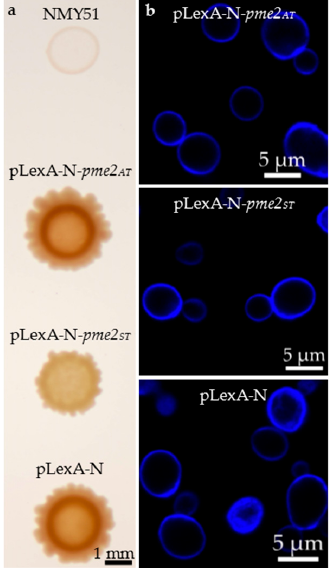
Figure 6. PME2 ST overexpression reduces viability of N. benthamiana mesophyll protoplasts. Mesophyll protoplasts were transformed with the plasmid pGGZ001 encoding mCherry-tagged PME2 ST (PME ST ) or the mCherry tag only (mCherry) and stained with fluorescein diacetate (FDA) to detect viable cells. Data represent the mean percentage of FDA-positive stained cells +/ – SE ( n = 3). The statistical difference between the two groups was determined by using a Student’s t -test and is indicated with an asterisk (* p < 0.05).